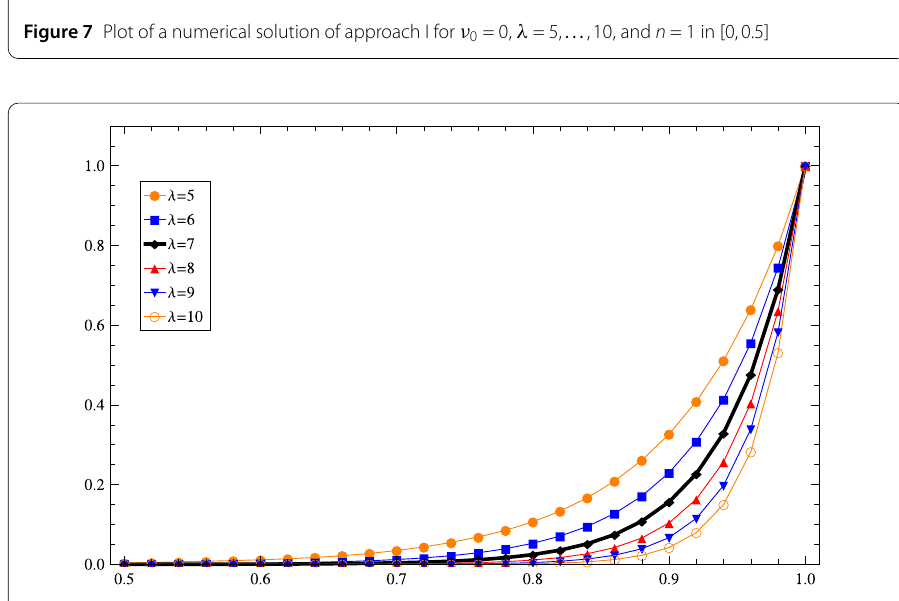
Figure 8 Plot of a numerical solution of approach I for ν 0 = 0, λ = 5, ... ,10, and n = 1 in [0.5,1]